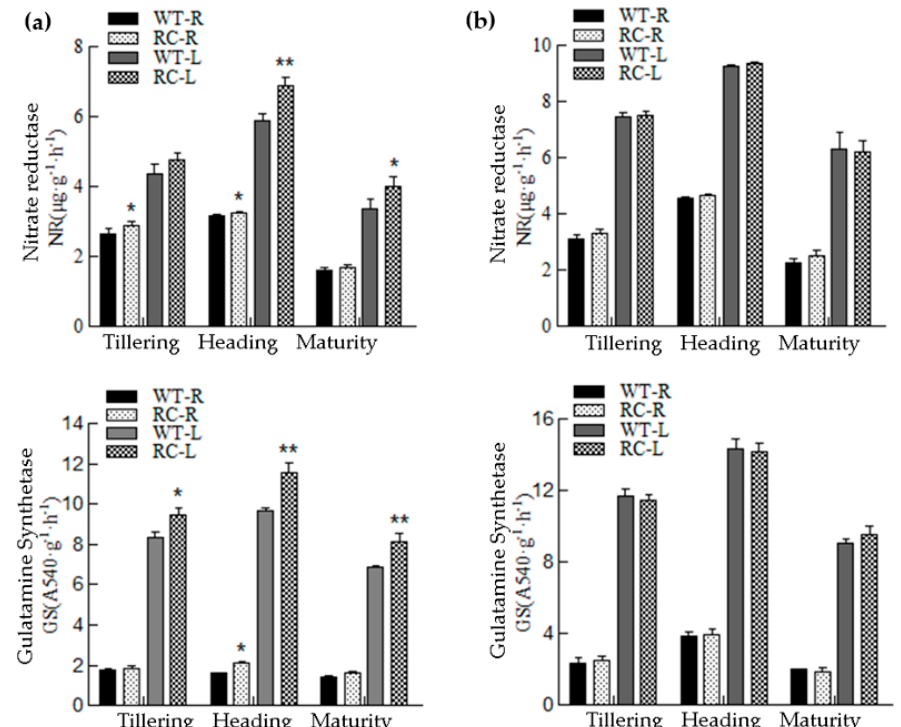
Figure 5. Nitrate reductase and glutamine synthetase activity of rice at different growth stages under different nitrogen treatments in pots. WT-R: Root of wild type; RC-R: Root of transgenic rice; WT-L: Leaf of wild type; RC-L: Leaf transgenic rice. ( a ) No nitrogen treatment—LN; ( b ) normal nitrogen treatment; NN. *, ** represent significance difference ( p < 0.05) calculated by LSD’s test.